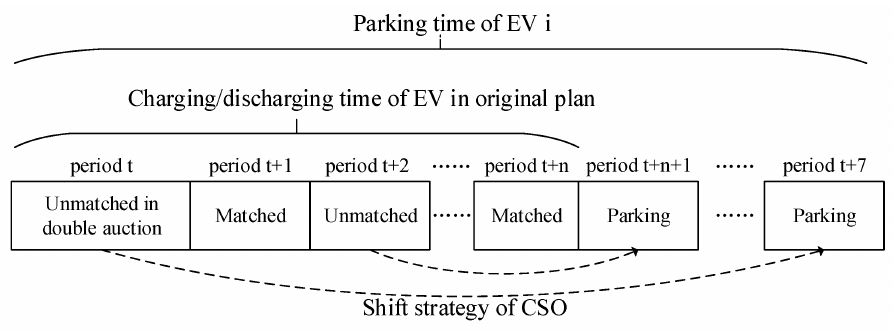
Figure 3. Shift strategy of CSO in smart match